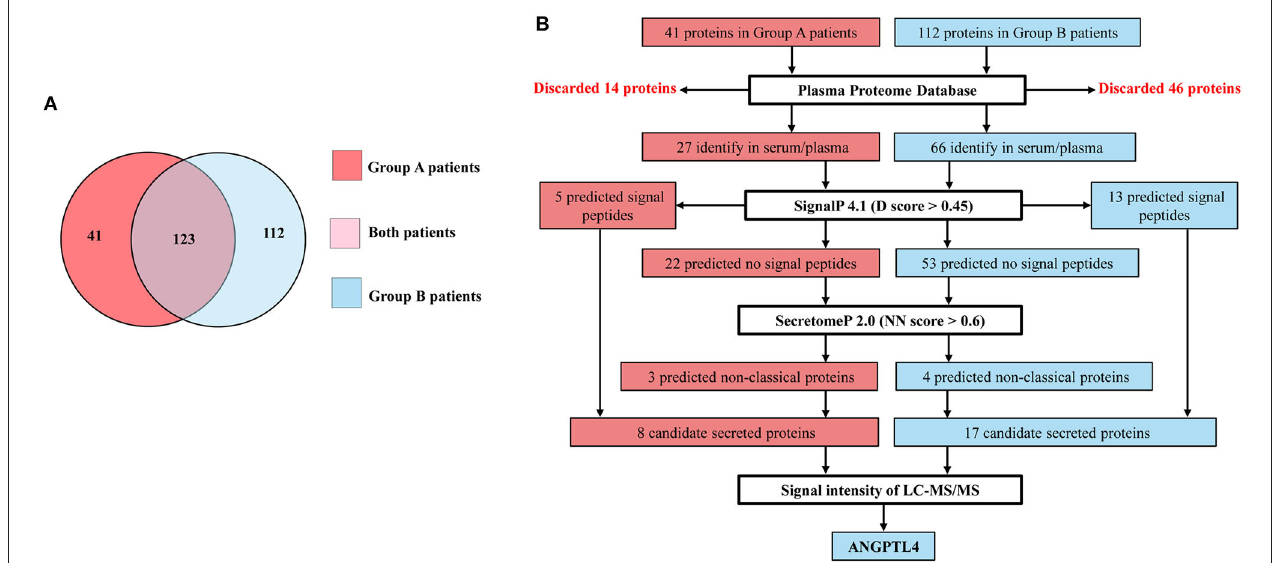
FIGURE 1 | (A) Venn diagram showing 123 proteins express in both, 41 and 112 proteins uniquely express in Group A patients (CCA with ≤ 1 year survival time) and Group B patients (CCA with > 1 year survival time). (B) Flow diagram of selection of candidate secreted proteins in Group A and Group B patients. Proteins identify in serum/plasma database and having signal peptide or non-classical proteins as candidate secreted proteins. ANGPTL4 is selected from Group B patients which express highest signal intensity of LC-MS/MS among candidate secreted proteins.